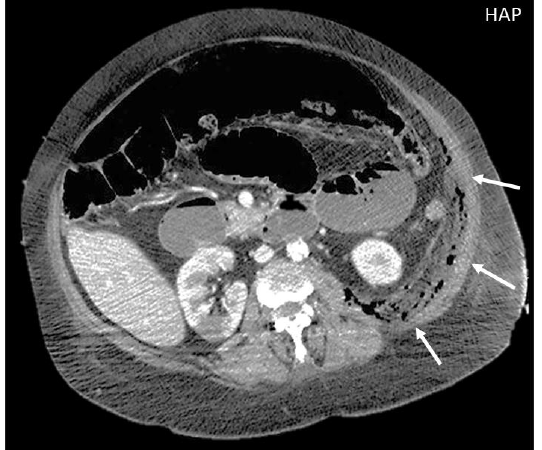
Figure 2. CT appearance of necrotizing fasciitis in a 58-year-old woman with a recent left lower limb open wound who arrived at the ER in septic shock. Arterial phase axial CT scan reveals the presence of free air in the fascial planes of the left lateral and posterior abdominal wall, with fascial thickening and lack of muscular enhancement, as compared to its counterpart (arrows). These elements are suggestive of necrotizing fasciitis. The patient was promptly referred to surgery, but she died on the operatory table.